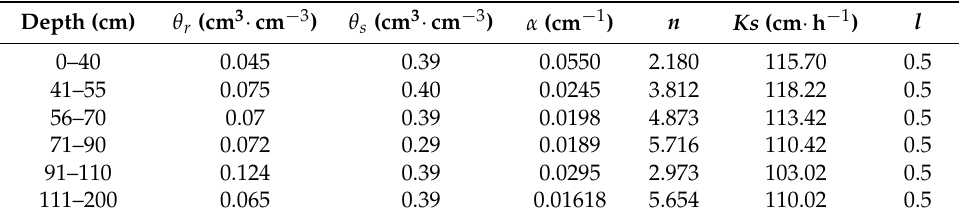
Table 3. The calibrated parameters for the HYDRUS-1D